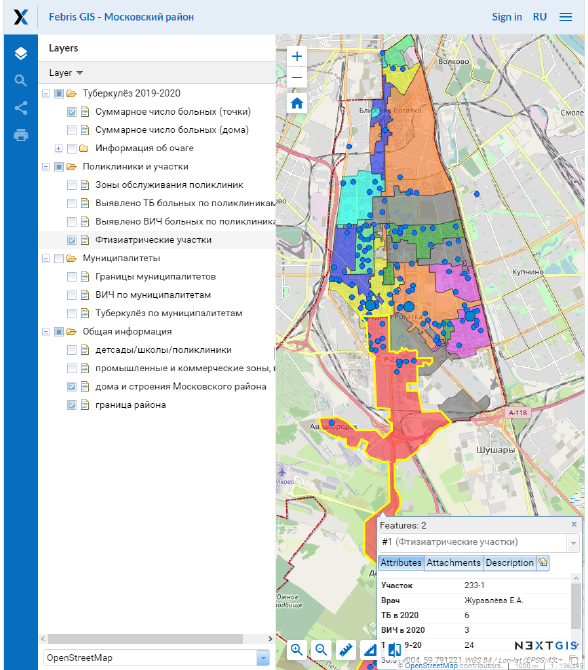
Figure 5. Web interface of the Febris GIS